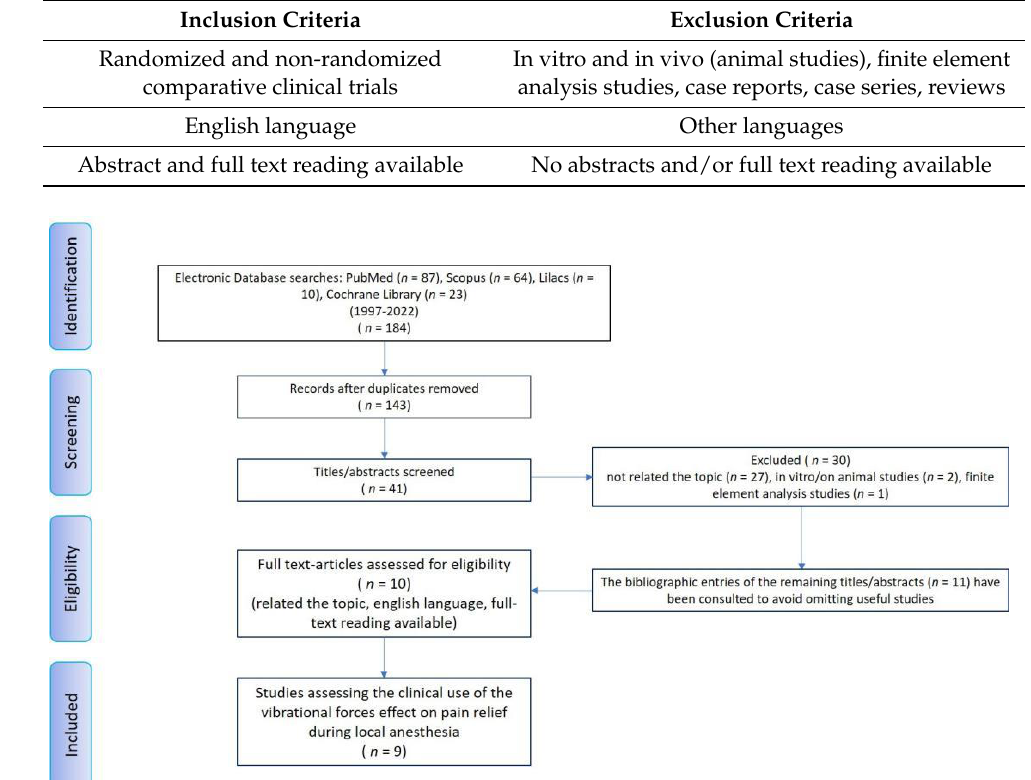
Table 2. Inclusion and Exclusion criteria.